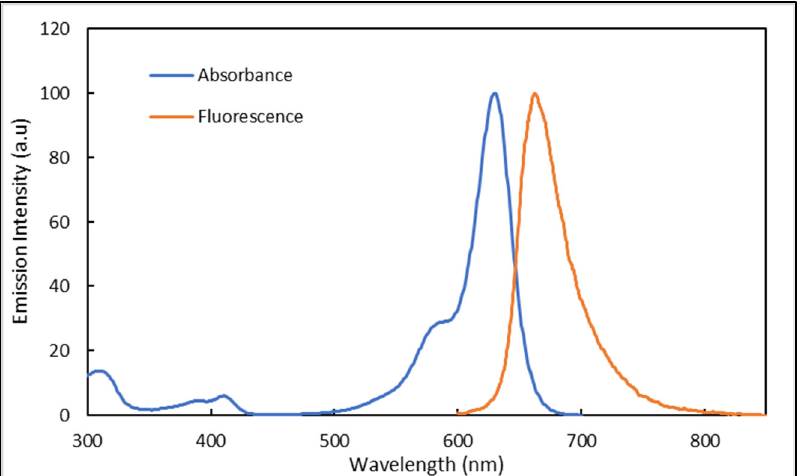
Figure 8. Absorbance and emission spectra of Atto 633 dissolved in water and a concentration of 1.2 × 10 −5 g/mL. Emission recorded with an excitation at 633